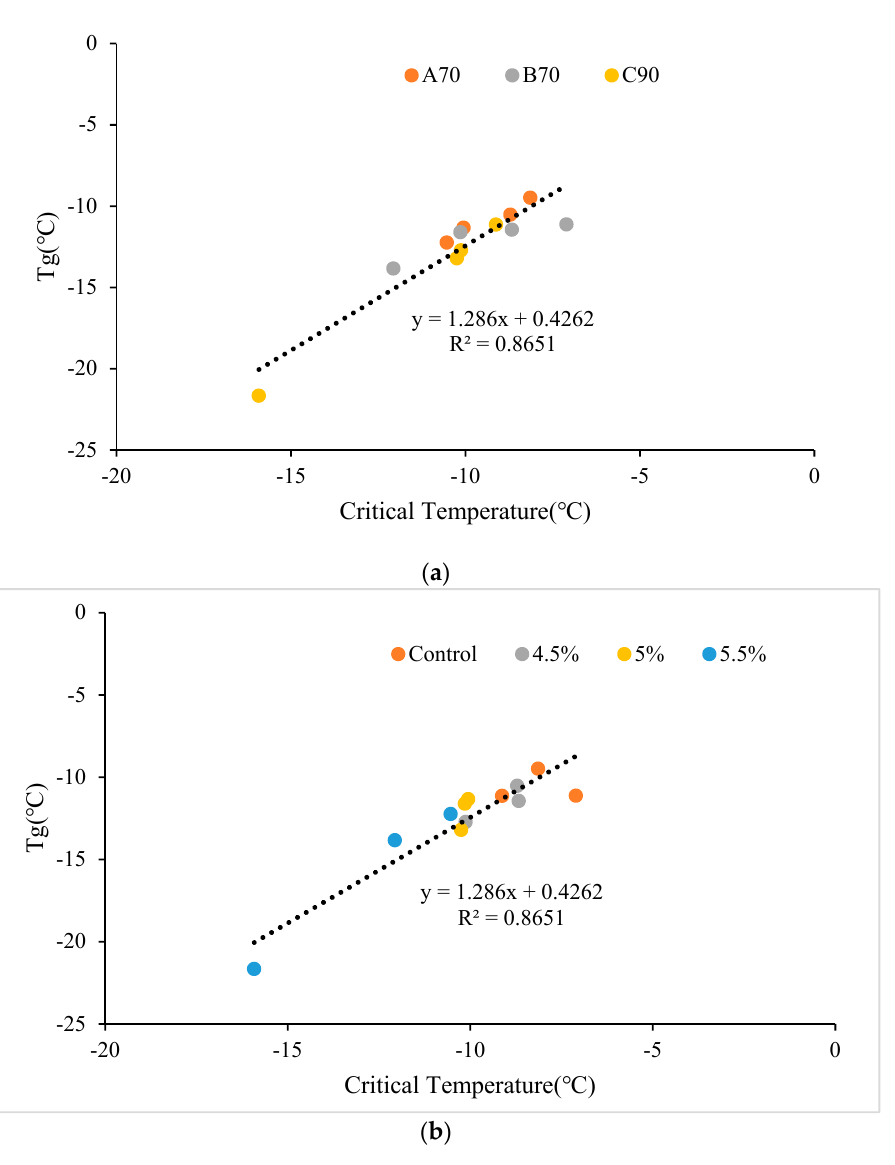
( a ) different binder sources. ( b ) g